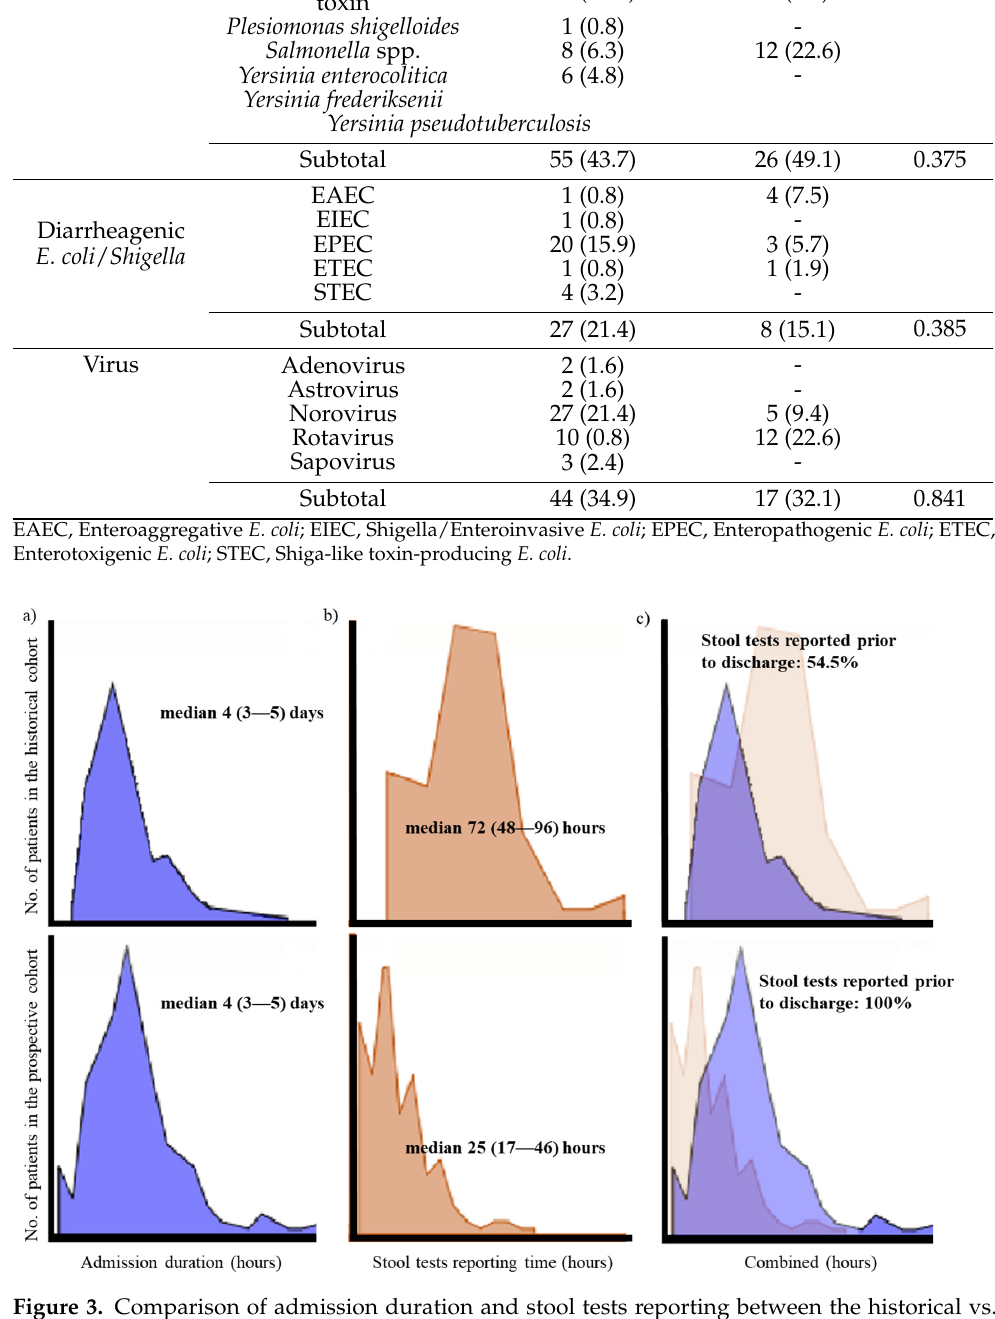
Figure 3. Comparison of admission duration and stool tests reporting between the historical vs. prospective cohort. ( a ) Although there was no significant difference in the admission duration of the patients in the historical vs. prospective cohort ( p = 0.079), ( b ) the stool reporting time was significantly longer in the historical cohort compared to the prospective cohort ( p < 0.001), ( c ) resulting in 45.5% of patients being discharged before receiving stool test results in the historical cohort.